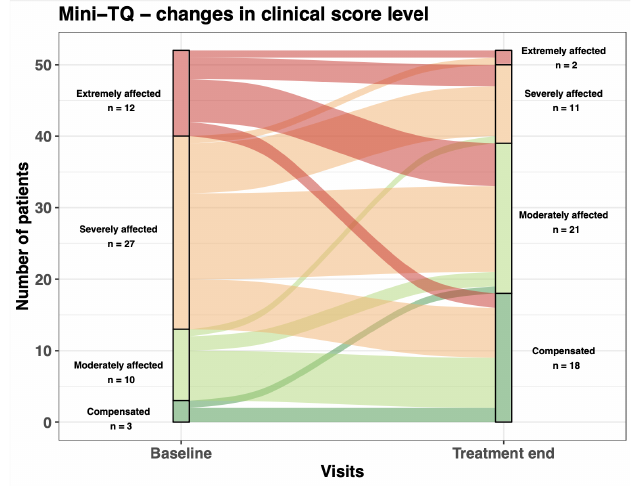
Figure 1. Changes in the tinnitus grades from before to after the group therapy. Sankey plot of changes in clinical score level based on the mini tinnitus questionnaire.